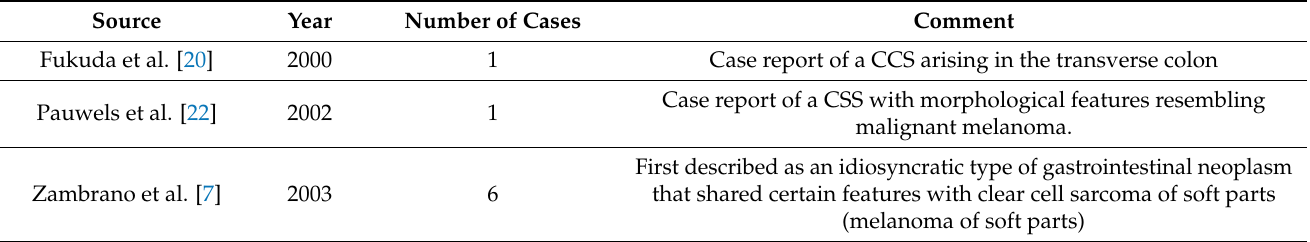
Table 3. Previously reported cases with